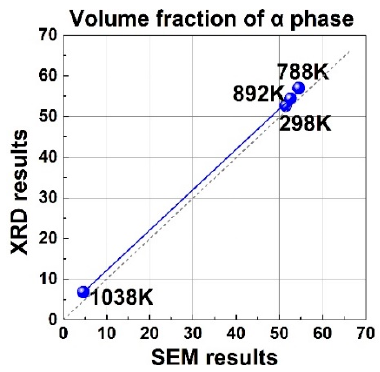
Figure 6. Linear regression of the α phase fraction derived from XRD versus those from SEM.